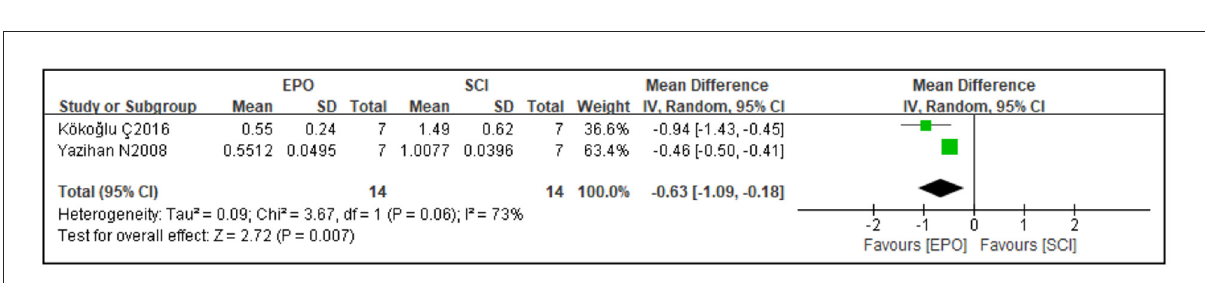
FIGURE5 Forest plot for the effects of EPO intervention on MDA in rats with SCI. EPO, erythropoietin; MDA,